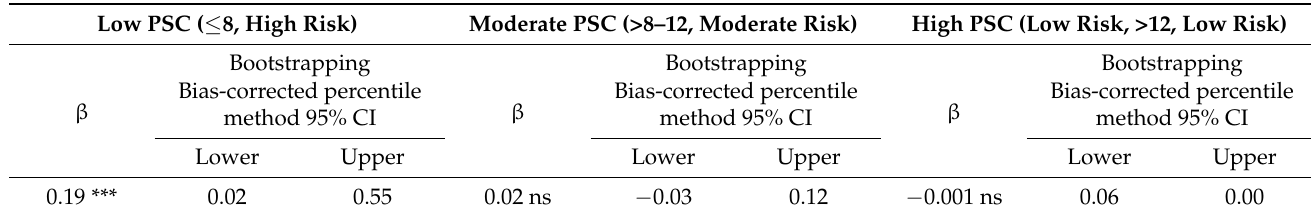
Table 5. Multi-group analysis of PSC: Conditional indirect effect of WI T 1 on PRTSM T 1 through WI T 2 (X on Y through M,